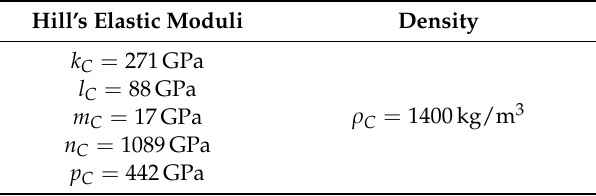
Table 1. Mechanical properties of a single CNT